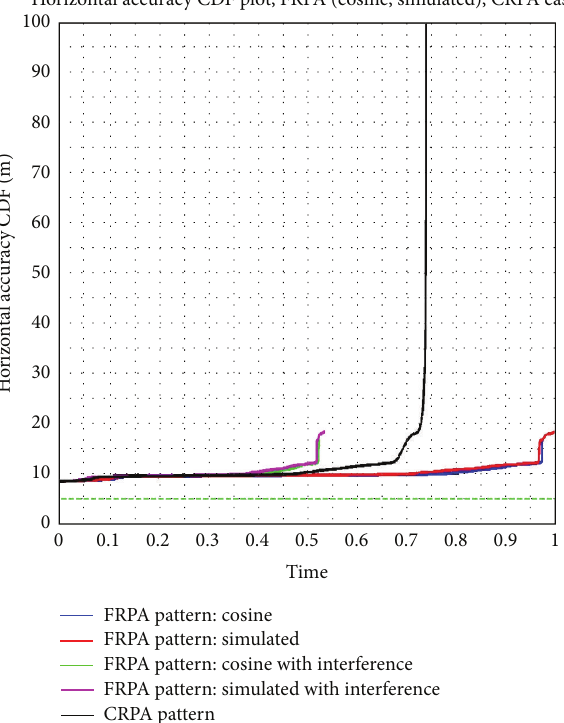
Figure 18: Horizontal accuracy CDF curve − 24/24GPS constella- tion and 2RF interfering